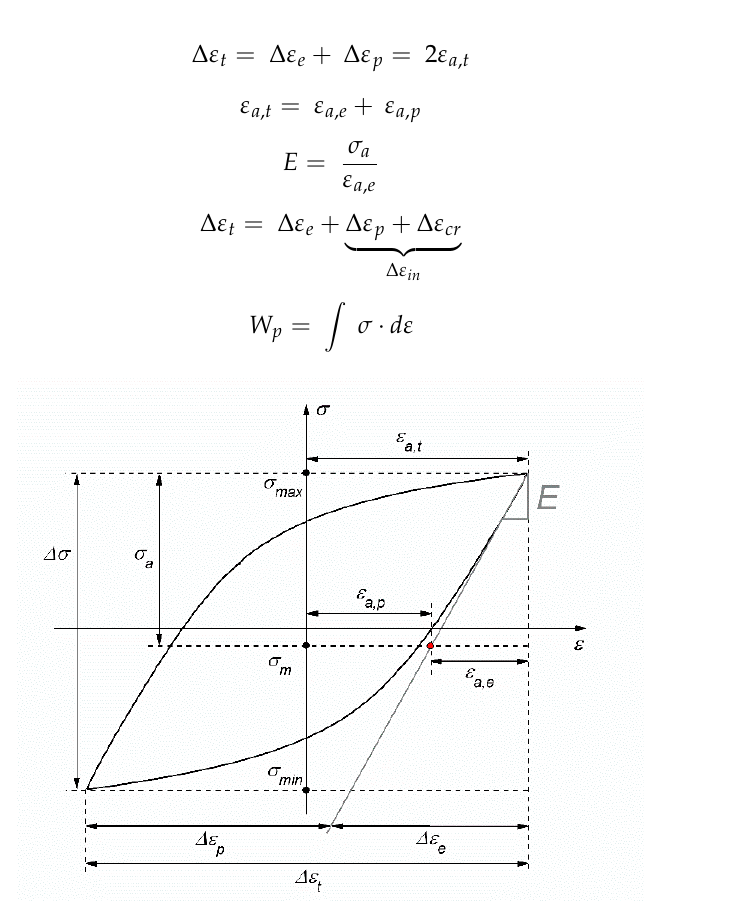
Figure 4. Schematic hysteresis loop for LCF-tests with characteristic quantities. Table 2. Young's modulus, E , of P92 at different temperatures obtained by sonic resonance. Temperature [°C]